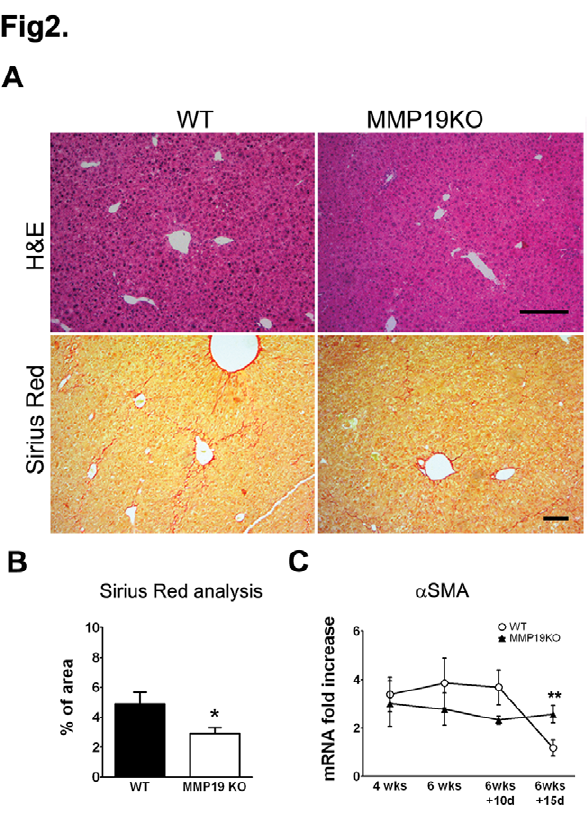
Figure 2. MMP19KOs show faster recovery from fibrosis than WTs. Mice treated with CCl 4 for 6 weeks were allowed 10 or 15 days for recovery. (A) After 15 days of recovery, significant parenchymal regeneration with less visible necrosis and fibrosis was observed in both WT and MMP19KO livers. (B) Fibrotic area (based on image analysis of Sirius red staining) was significantly lower in MMP19KOs after 15 days of recovery. (D) a SMA mRNA expression was slightly higher in WTs than in MMP19KOs throughout the course of liver damage progression but failed to drop during the recovery. Images were originally taken at 100 6 (H&E) and 50 6 (Sirius Red) magnification, scale bars=200 m m. *p , 0.05, MMP19s vs. WTs; 5–9 animals of each strain were analyzed at each time point.